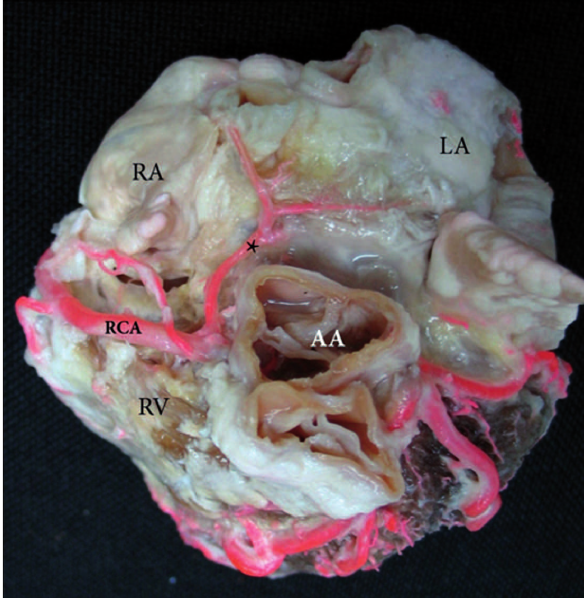
Fig. 3 - Superior heart view. Sinoatrial node artery originated from right coronary’s proximal segment (*). RCA: Right coronary artery. RV: Right ventricle. RA: Right atrium. LA: Left atrium. AA: Aortic artery